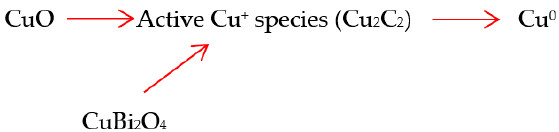
Figure 13. Activation process scheme of CuO and CuBi 2 O 4.